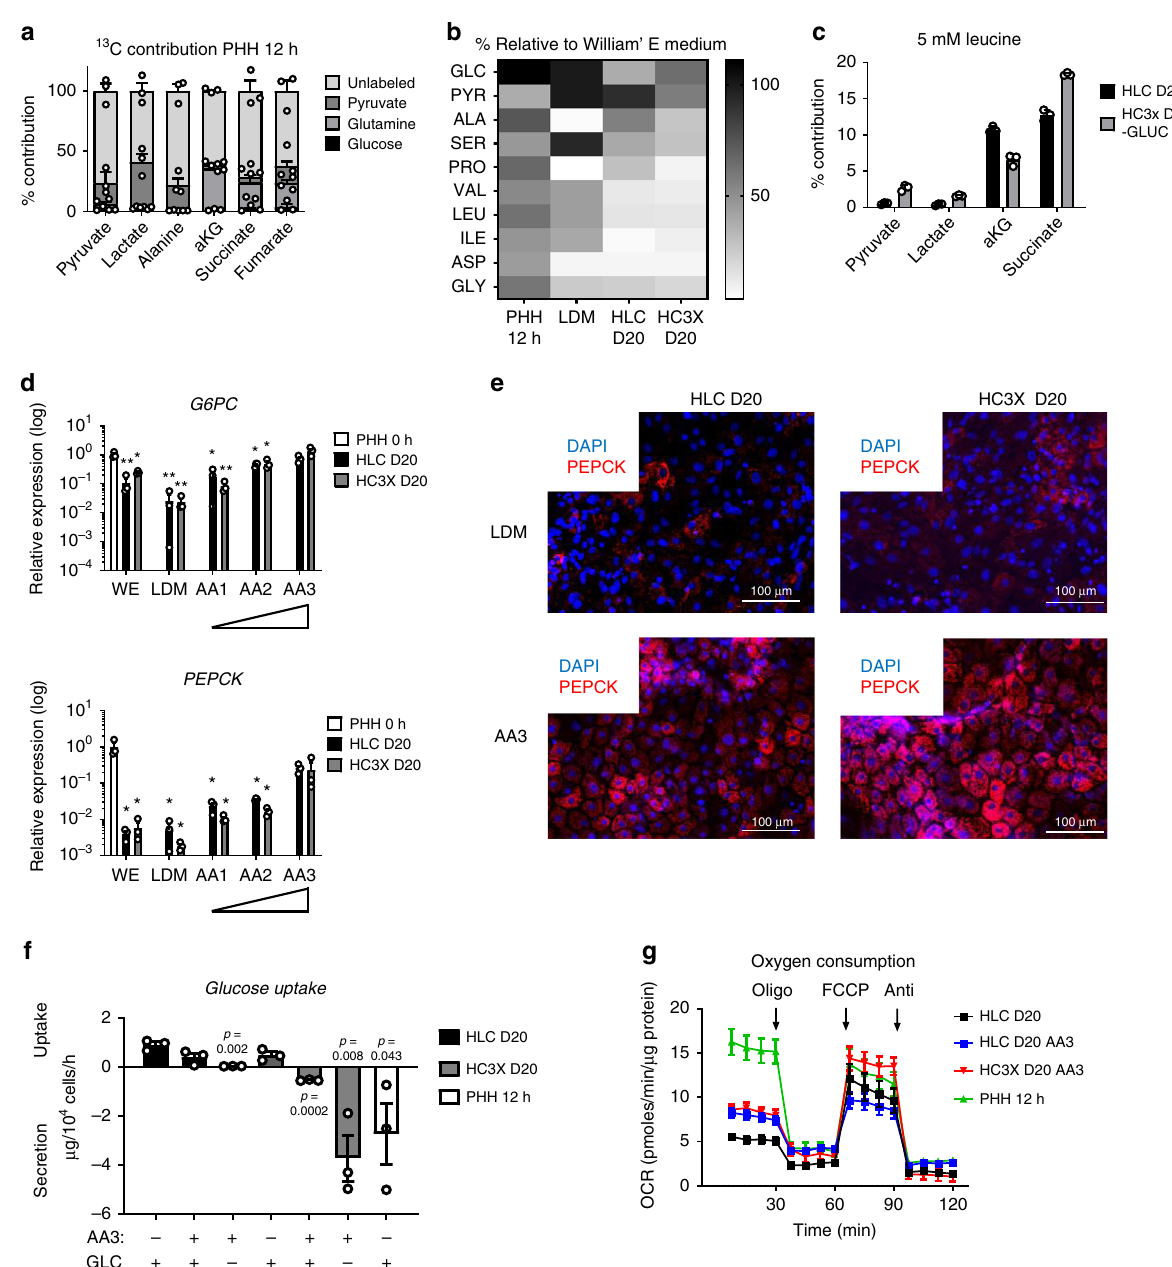
Fig. 3 AA supplementation induces metabolic maturation in HLC- and HC3X D20. a Percentage of labeling derived from 13 C-labeled glucose, glutamine, or pyruvate in PHH 12 h. N = 3 donors. b Relative concentrations of glucose, pyruvate, and the amino acids alanine (ALA), serine (SER), proline (PRO), valine (VAL), leucine (LEU), isoleucine (iLEU), aspartate (ASP), and glycine (GLY) in culture medium of PHH 12 h, HLC D20, or HC3X D20. N = 3 independent differentiations. N = 3 for each of 2 PHH donors. c Percentage of contribution of 5mM of 13 C leucine in HLC D20 and HC3X N = 3 independent differentiations. d Relative gene expression analysis for G6PC and PEPCK for HLC D20 and HC3X D20 compared with PHH 0 h. Cells were cultured in either WE or LDM supplemented with increasing amounts of amino acids ( N = 3 independent differentiations. N = 4 donors for PHHs). Signi fi cance was calculated compared with PHH 0 h grown in William ’ s E (WE) by unpaired two-tailed Student ’ s t -test. * p < 0.05, ** p < 0.01. e Representative immuno fl uorescence images of two independent differentiations for PEPCK staining of HLC D20 and HC3X D20 cultured in LDM or AA3. f Glucose uptake or secretion in HLC D20 and HC3X D20 cultured in control medium or AA3 with or without glucose (GLC). Secretion rates for PHH 12h were used as reference and repeated from Fig. 1f. N = 3 independent differentiations, N = 3 donors for PHHs. Signi fi cance was calculated by comparing HLC D20 in LDM with glucose (GLC) and samples of HLC or HC3X cultured with or without AA3 and with or without GLC by using unpaired two-tailed Student ’ s t -test. g Oxygen consumption measurement with addition of oligomycin, FCCP, and antimycin for HLC D20 and HC3X D20 cultured with AA3 without glucose. Data for HLCs and PHH 12h was used as a reference and repeated from Fig. 1g. N = 6 wells, 5 time point measurements per well. PHH = N = 6 wells for 2 different donors, 5 time point measurements per well. Data in all panels represent mean ±SEM with P -values indicated when signi fi cant. Source data are provided as a Source Data fi